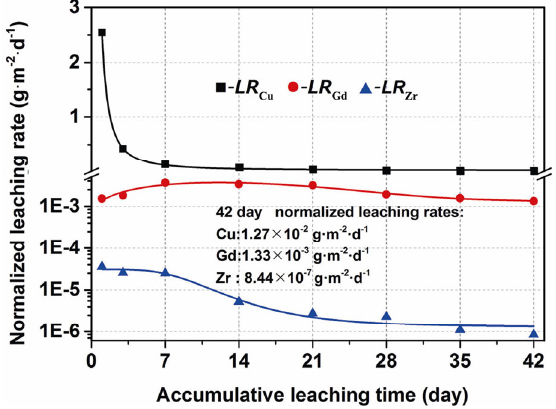
portant Fig. 8 Normalized elemental leaching rates (Zr-35) of Cu, Gd, and Zr using standard MCC-1